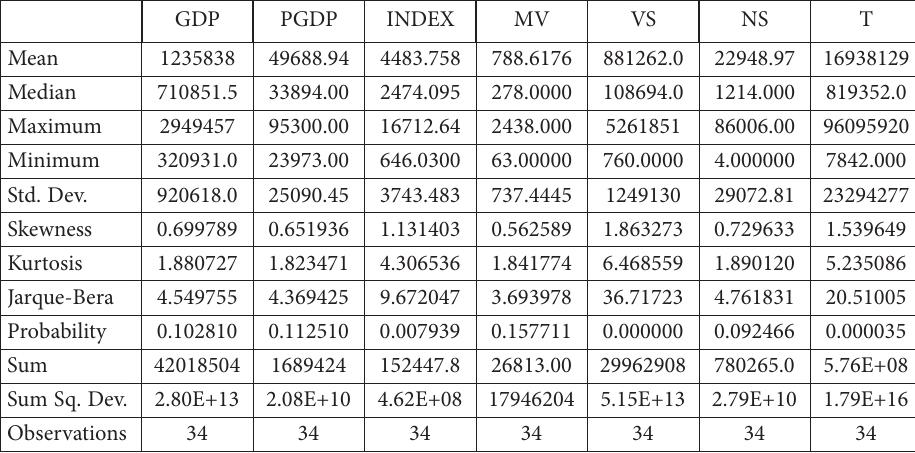
Table 1. Descriptive statistics of gross domestic product (GDP), Per-capita gross domestic product (PGDP), Total market capitalization (MV), Total number of shares traded (NS), Share price Index (INDEX), Total Volume of Transactions (T), and value of shares (VS) for the period 1985–2018 (source: Saudi Arabian Monetary Agency [SAMA],